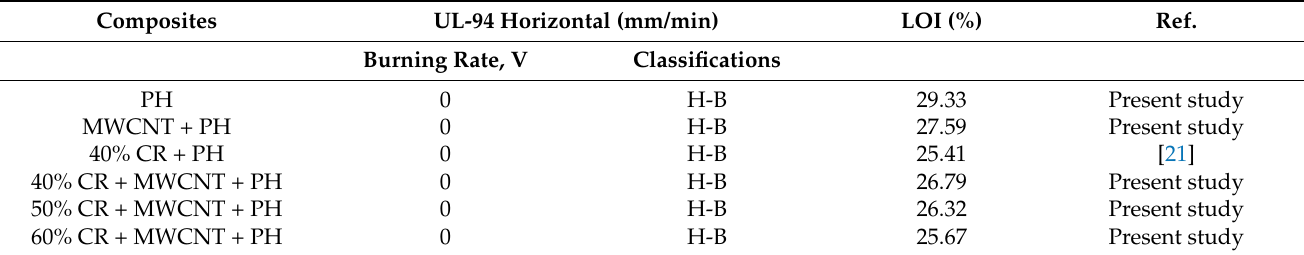
Table 5. UL 94 and LOI for CR fiber-reinforced MWCNT-phenolic composites. Composites UL-94 Horizontal (mm/min) LOI (%) Ref. Burning Rate, V